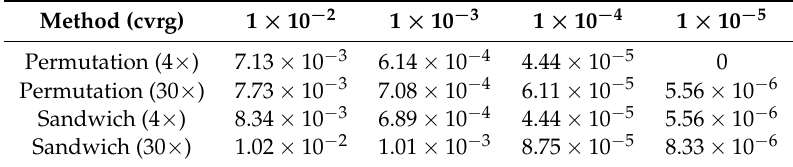
Table 1. Empirical rejection rates under null settings for level 1 × 10 − 2 ,1 × 10 − 3 ,1 × 10 − 4 , and 1 × 10 − 5